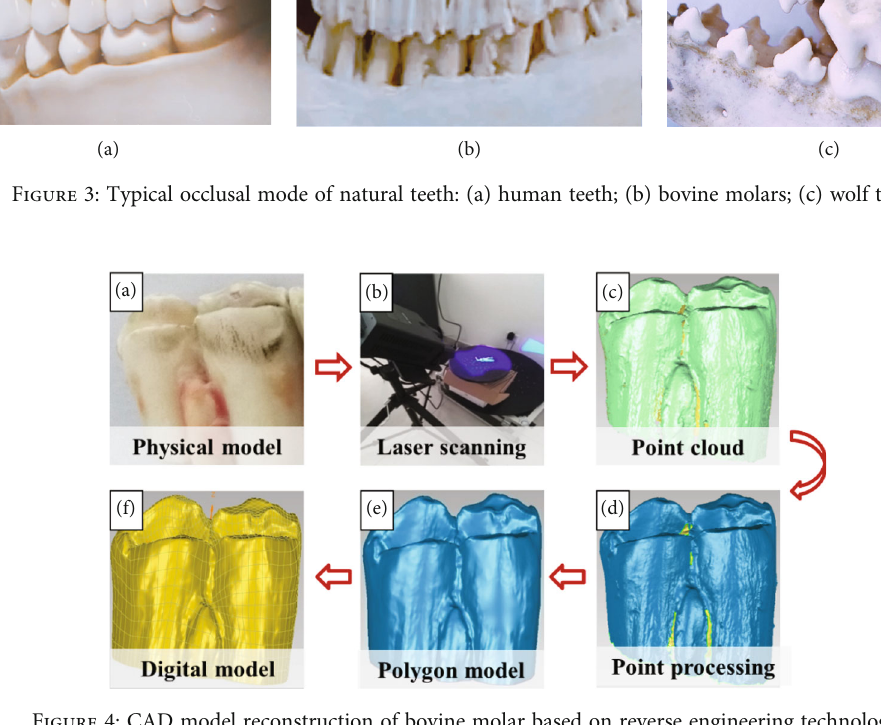
Figure 4: CAD model reconstruction of bovine molar based on reverse engineering technology.